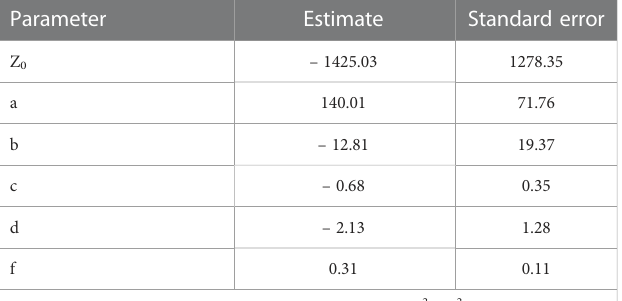
TABLE 2 Parameter estimates of the non-liner regression model describing the co-in fl uence of temperature and relative humidity (RH) on the concentration levels of Pseudomonas amygdali pv. lachrymans ( Pal ) in aerosols.